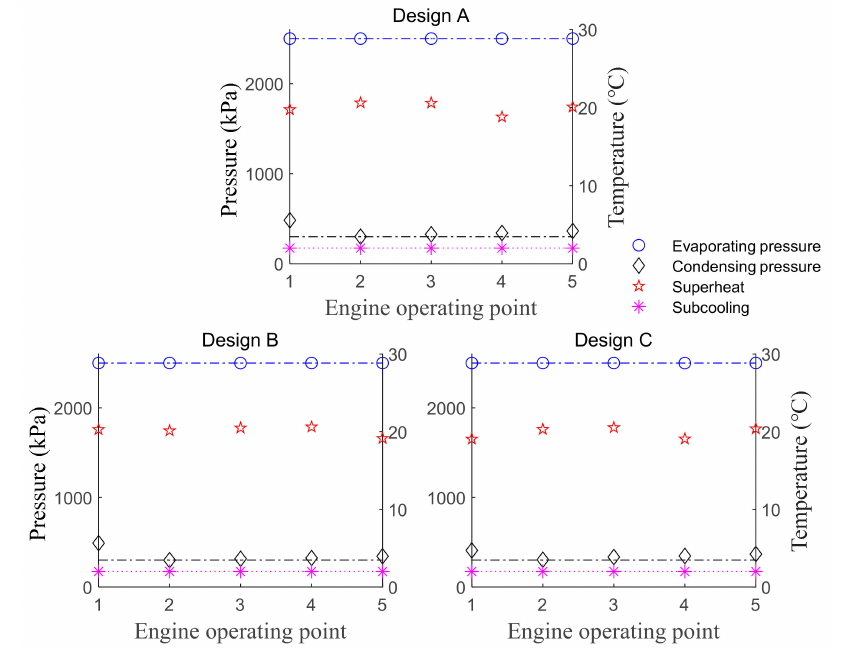
Figure 8. The optimal operating parameters of each design method.